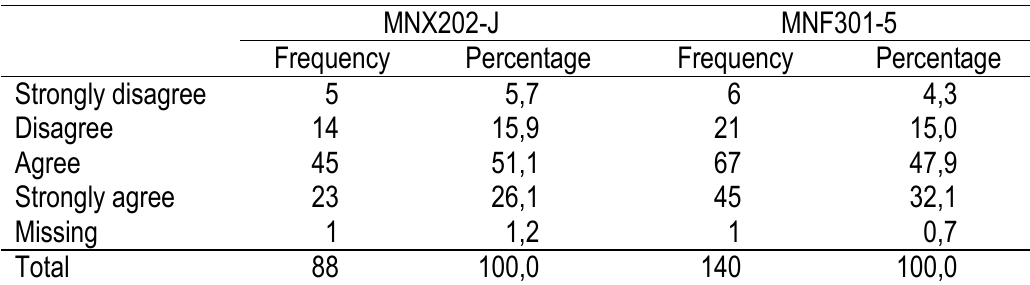
Table A6: The feedback on my assignment helped me with my studies